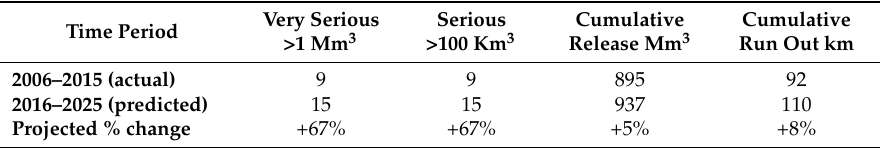
Table 1. Anticipated increases in frequency & severity